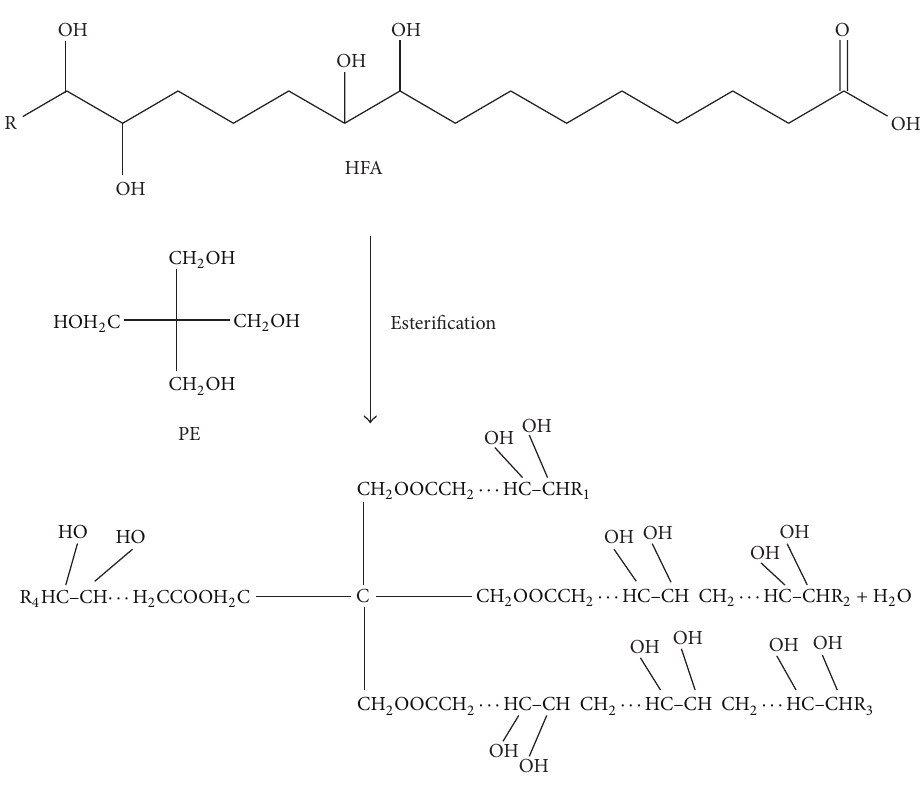
Figure 2: Synthesis of SEP over a phosphotungstic acid catalyst.